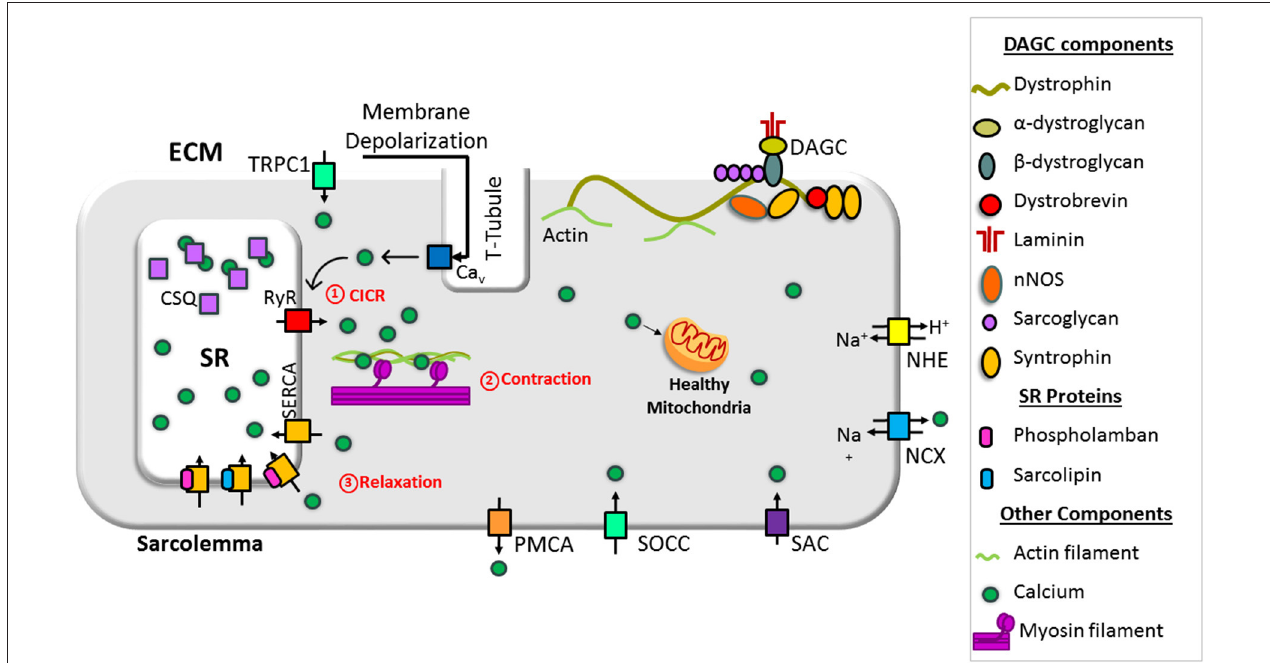
FIGURE 1 | Schematic representation of intracellular Ca 2 + cycling in a normal muscle cell. Dystrophin stabilizes muscle cells by linking the cytoskeleton (F-actin, intermediate filaments, microtubule) to the extracellular matrix via the dystrophin-associated glycoprotein complex (DAGC). Ca 2 + -induced Ca 2 + release (CICR) occurs through activation of voltage-gated, L-type Ca 2 + channels (Ca v ) and the release of Ca 2 + from the sarcoplasmic/endoplasmic reticulum (SR) via ryanodine receptor (RyR). CICR activates muscle contraction. Resequestration of Ca 2 + back into the SR by SR Ca 2 + ATPase (SERCA) initiates muscle relaxation. The physiological intracellular Ca 2 + level regulates mitochondrial Ca 2 + content and function and maintains cellular energetics. DG, dystroglycan; NCX, sodium–calcium exchanger; NHE, sodium–proton exchanger; PMCA, plasma membrane Ca 2 + ATPase; SAC, stretch-activated channels; SOCC, store-operated Ca 2 + channel; TRPC1, transient receptor potential channel